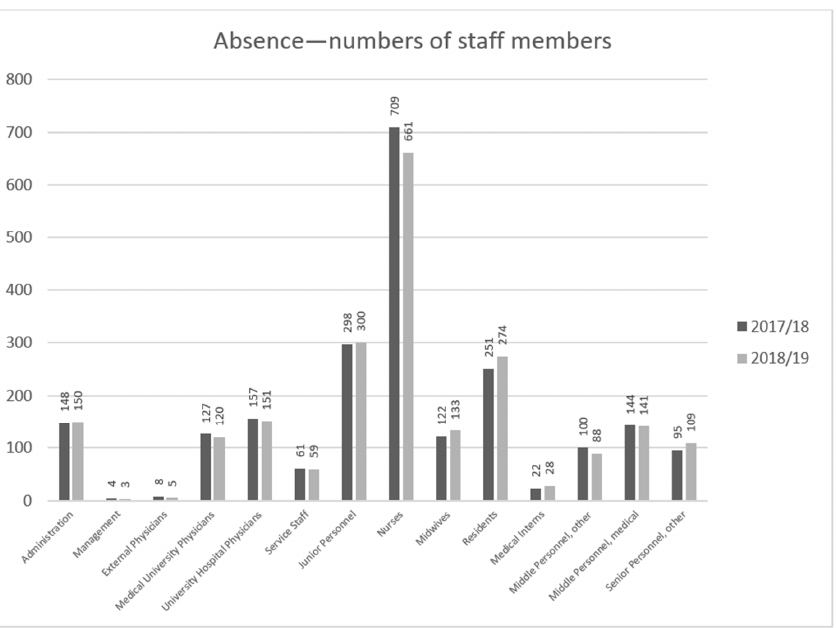
Figure 3. Hospital employees with reported absence due to illness during the 2017–2018 and 2018–2019 flu seasons, by healthcare professional group.